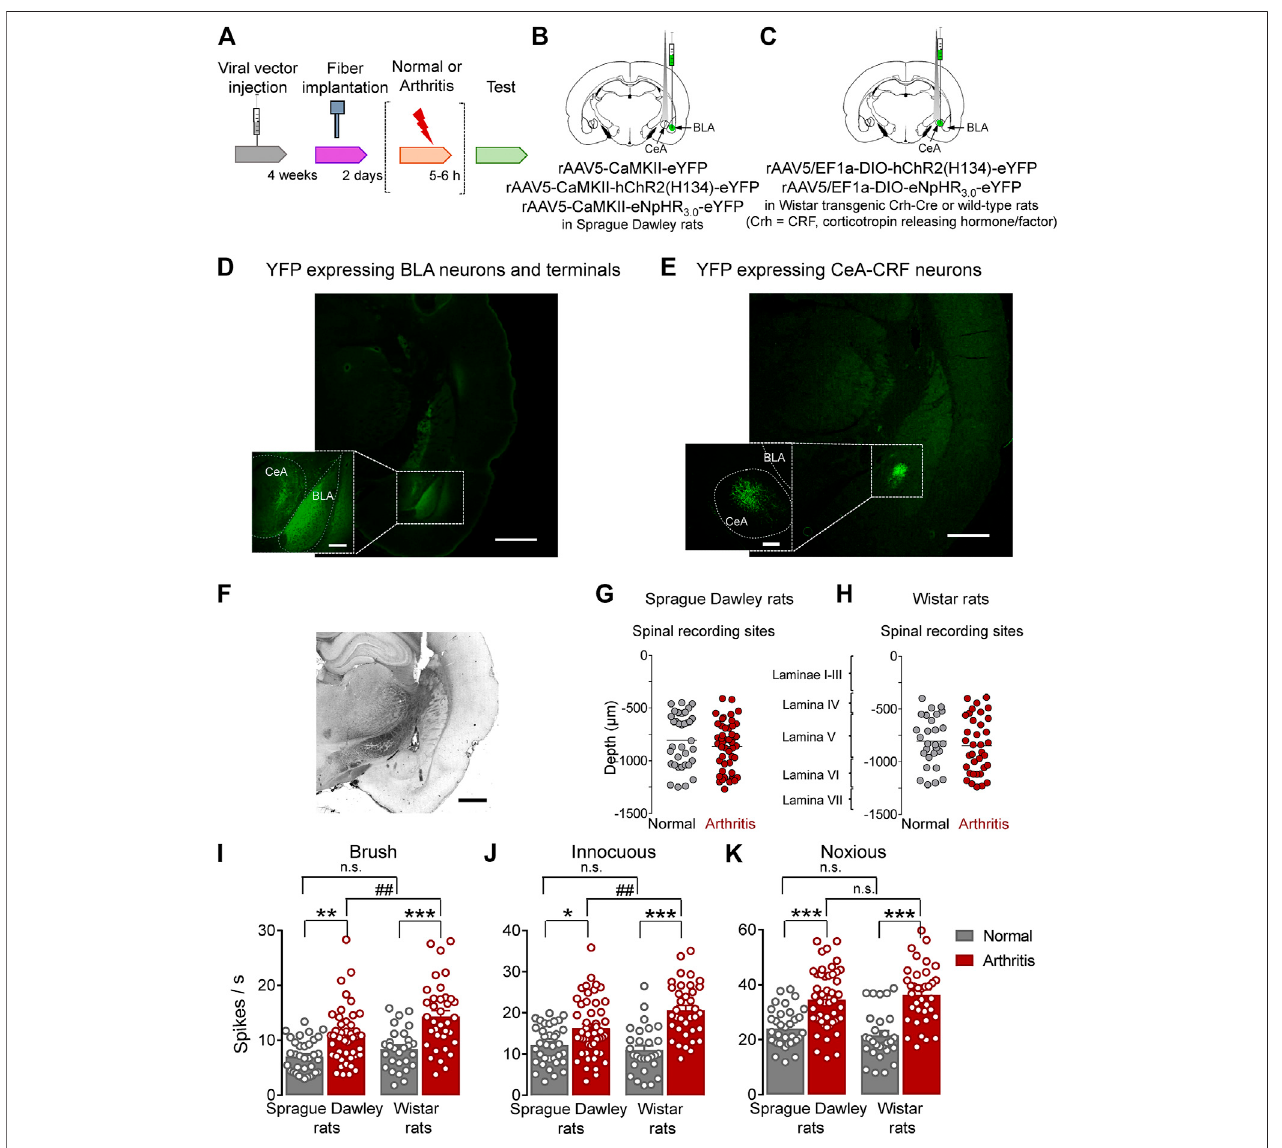
FIGURE 1 | Overview of experimental strategy and arthritis pain-related changes in spinal dorsal horn neurons. (A) Experimental design. (B) Schematic illustration of viral vector injection into the BLA to express light – sensitive channels under the control of CaMKII in BLA – CeA axon terminals, and application of light into CeA. (C) SchematicillustrationoftheinjectionoftheCre-inducibleviralvectorintotheCeAtoexpresslight – sensitivechannelsinCRFneurons,andapplicationoflightintoCeA. (D) Representative image of viral vector – mediated YFP expression in BLA and YFP expressing BLA axon terminals in CeA (green, eYFP). Scale bars, 1000 µm (lower magni fi cationimage),200 µm(highermagni fi cationimage). (E) Representativeimageofviralvector-mediatedYFPexpressioninCeA – CRFneurons(green,eYFP).Scale bars, 1000 µm (lower magni fi cation image), 200 µm (higher magni fi cation image). (F) LED fi ber track intothe CeA. Scale bar 1000 µm (G) Depthsof recording electrode tips from the dorsal surface of the spinal cord of Sprague Dawley rats. (H) Depths of recording electrodes in the spinal cord of Wistar rats. Also shown is the estimated correlation with dorsal horn laminae. (I – K) Spinal neuronal activity evoked by brushing the skin (I) and innocuous (J) and noxious (K) compression of the left knee joint was increased in arthritic SD and arthritic Wistar rats compared to normal naïve rats. In normal naïve rats, no signi fi cant difference was found in evoked responses between SD and Wistar strains. In the arthritis pain model, neuronal activity evoked by innocuous (I, J) , but not noxious (K) , stimulation of the arthritic knee was signi fi cantly higher in arthritic Wistar rats than arthritic SD rats. Bar histograms show means ± SEM. SD: Normal, n (cid:1) 35 in 13 rats; Arthritis, n (cid:1) 48 in 18 rats; Wistar: Normal, n (cid:1) 28 in 12 rats; Arthritis, n (cid:1) 36 in 14 rats. *, **, *** p < 0.05, 0.01, 0.001 compared to normal; p < 0.01 compared to SD; one – way ANOVA with Bonferroni posthoc